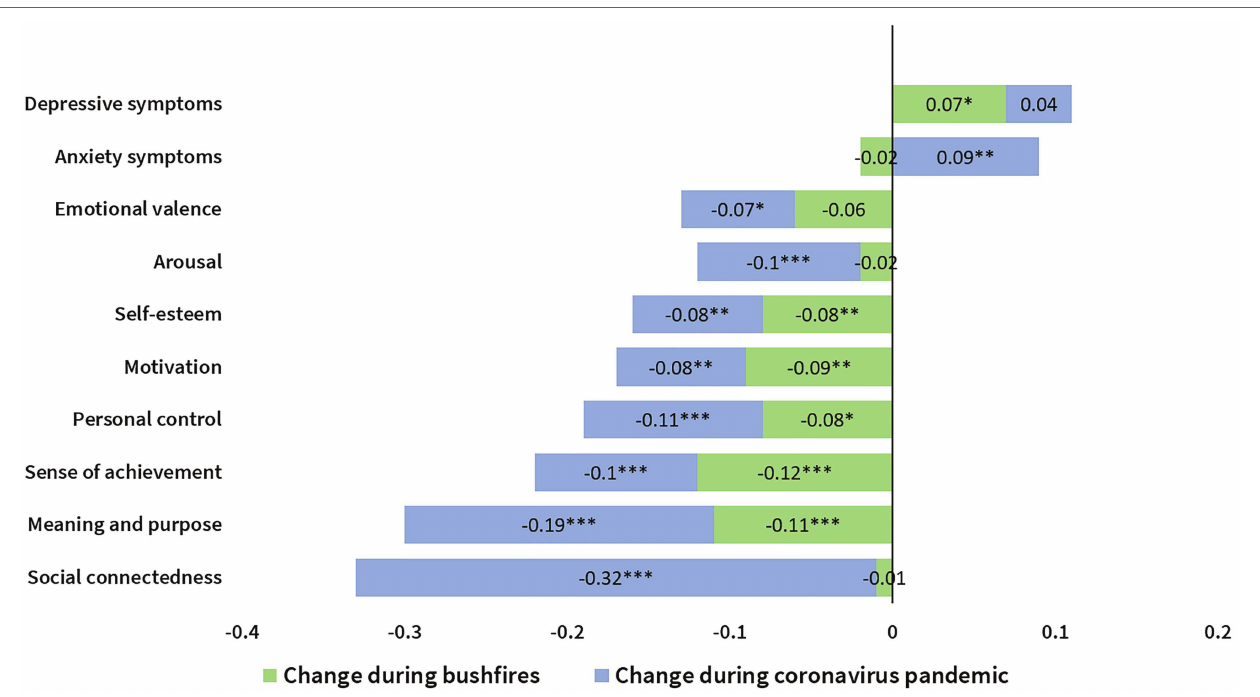
FIGURE 1 | Visual representation of effect sizes for all measures in response to Bushfires (green bars) and COVID-19 pandemic (blue bars) relative to the baseline